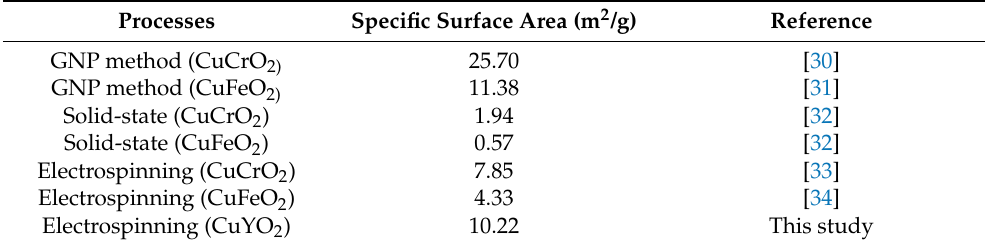
Table 1. Specific surface areas of the delafossite complexes prepared by various